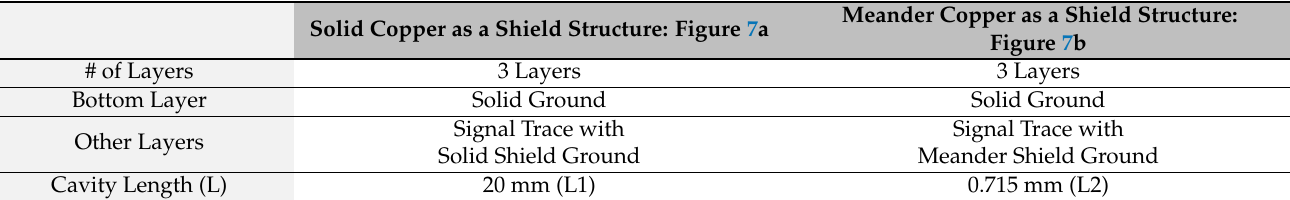
Figure 7. Length of structure in which a cavity resonance occurs between GND and shield GND. ( a ) When shield GND is solid copper, L = L1 and ( b ) When shield GND is meander copper, L = L2. Table 1. Comparison of structural information for Figure 7. Solid Copper as a Shield Structure: Figure